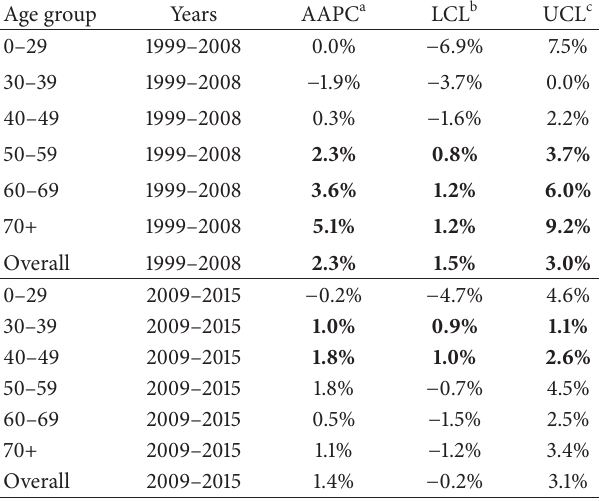
Table 2: Average annual percent change (AAPC) in breast cancer incidence rates/100,000 person-years by age group and year of diagnosis, 1999–2008, and predictions for breast cancer